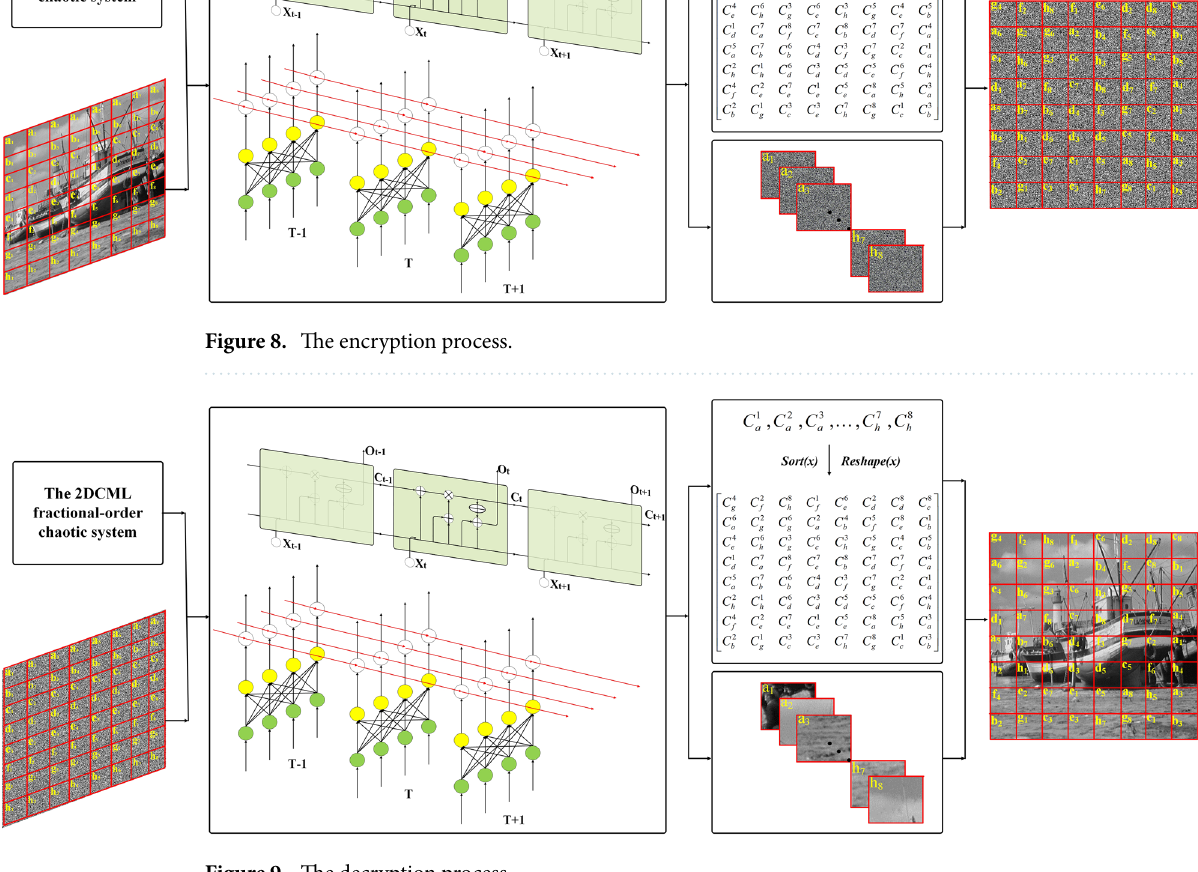
Figure 9. The decryption